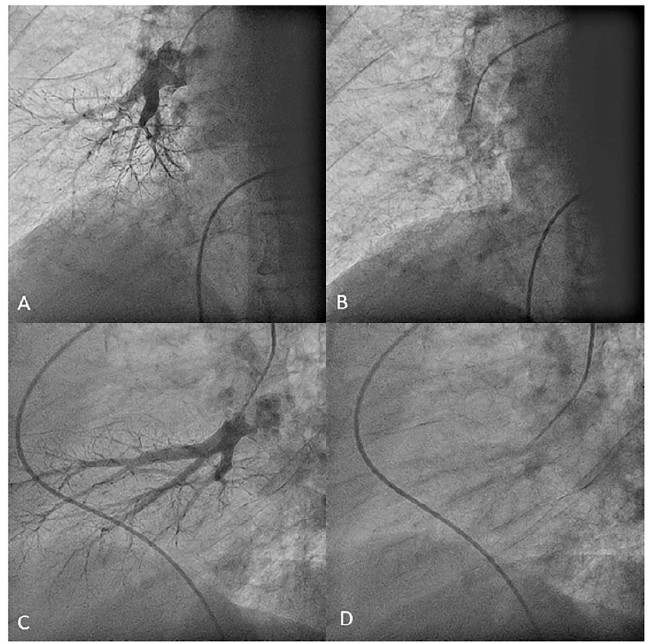
Figure 30. MP catheter canulating the middle lobe artery. ( A , B ) Anteroposterior and ( C , D ) lateral views.